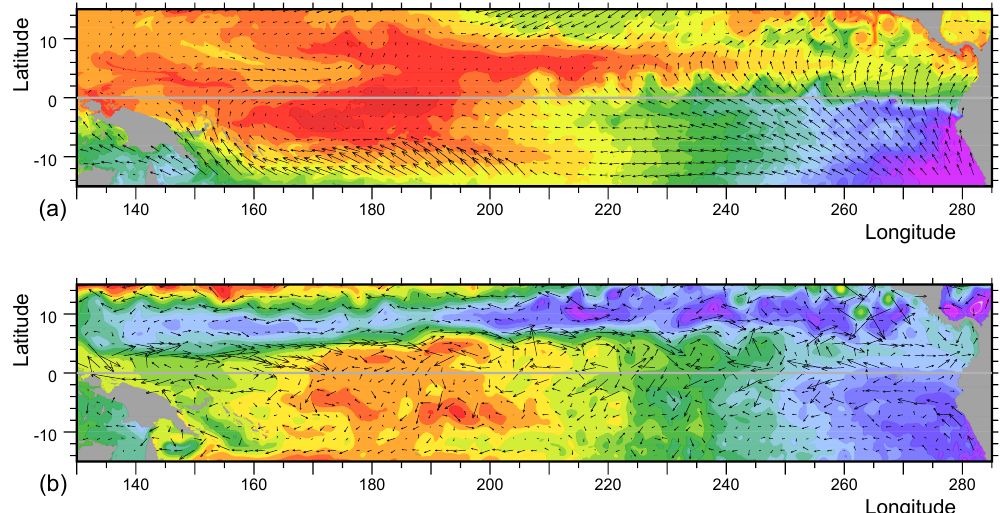
Figure 24. (a) Surface temperature and wind stress vectors. (b) SSH and velocity vectors are from the 27 September 1982 archive dataset. Colours and vector scales are as in Fig. 22.